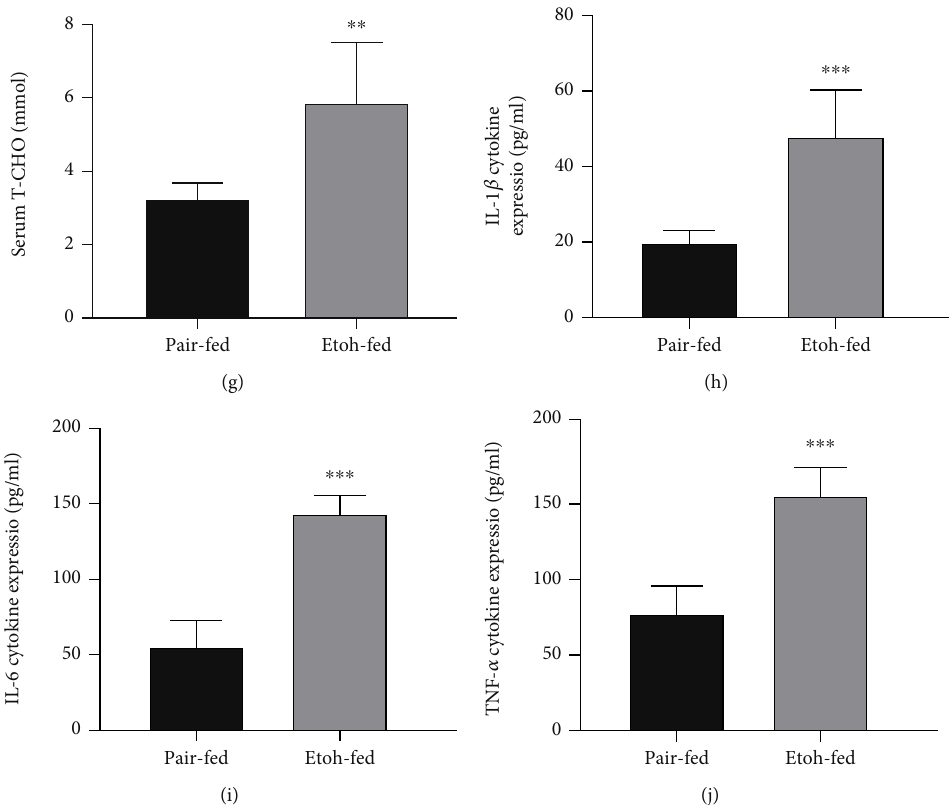
Figure 5: The establishment of animal models. (a) Representative H&E staining of liver sections (original magni fi cation: 200x, scale bar = 50 μ m ). (b) Representative oil red staining of liver sections (original magni fi cation: 200x, scale bar = 50 μ m ). (c) Liver index. (d – g) The serum levels of AST, ALT, TG, and T-CHO. (h – j) The serum levels of IL-1 β , IL-6, and TNF- α . ∗ P < 0 : 05, ∗∗ P < 0 : 01, and ∗∗∗ P < 0 : 001 compared with the Pair-fed group. # P < 0 : 05, ## P < 0 : 01, and ### P < 0 : 001 compared with the EtOH-fed group. The data represent the mean ± S : D : of at least three independent